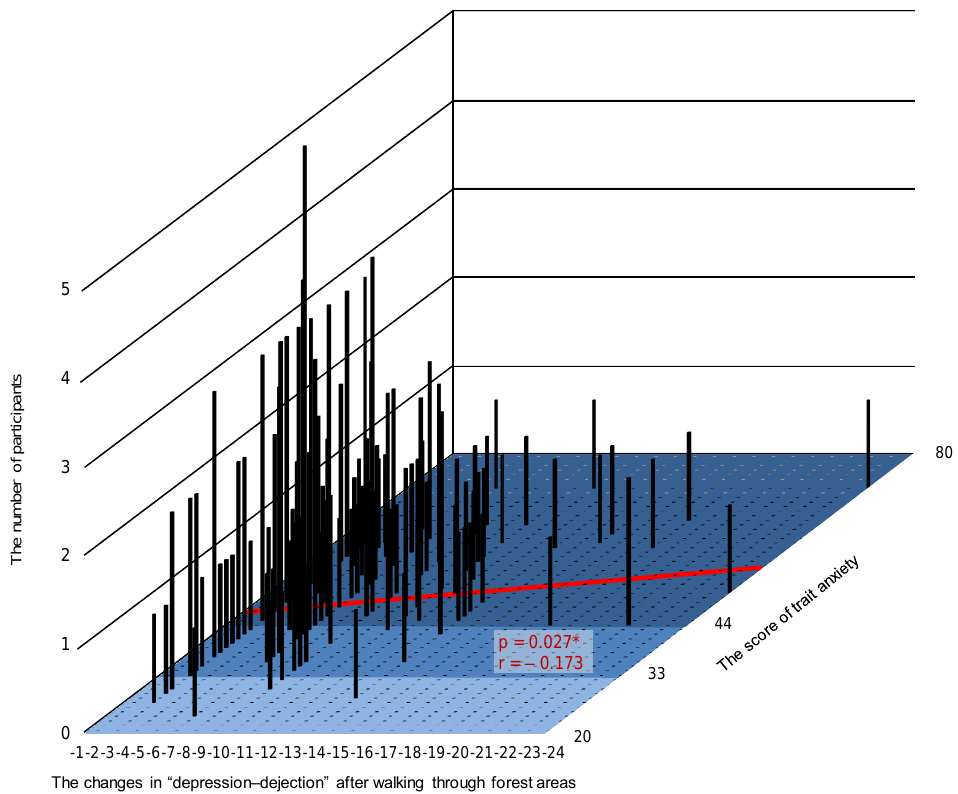
Figure 5. Three-dimensional graph on the changes in “depression–dejection” after walking through forest areas, trait anxiety score, and number of participants in the decreasing group. N = 163; *, p < 0.05 by Pearson’s correlation test.